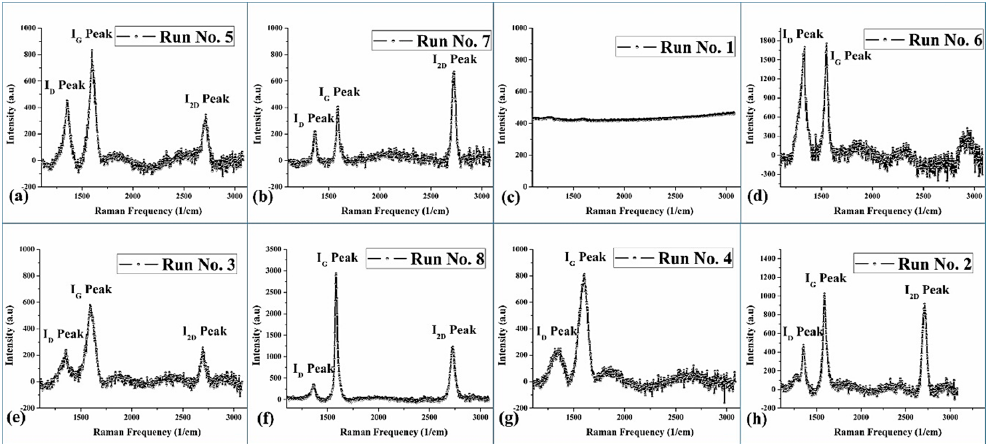
Figure 1. Raman Spectra for all eight experimental runs (as mentioned in Table 2). The Raman spectrum from ( a ) to ( h ) corresponds to experimental Runs 5, 7, 1, 6, 3, 8, 4, 2, respectively.